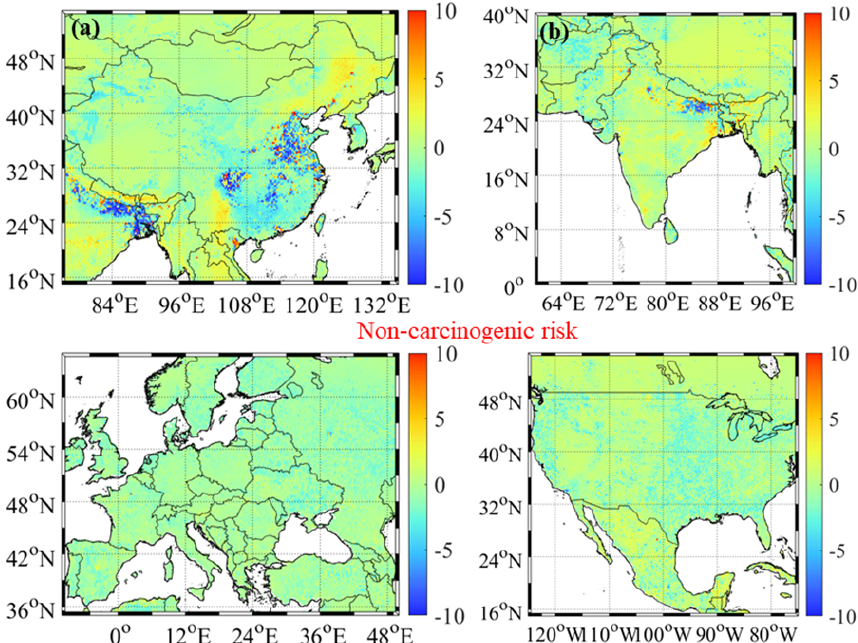
Figure 6. The non-carcinogenic risk differences (unit: 10 − 3 ) for atmospheric benzene between the COVID-19 period in 2020 and the same period in 2019 in (a) East Asia, (b) South Asia, (c) Europe, and (d) North America (difference = benzene concentration in 2020 − benzene concentration in